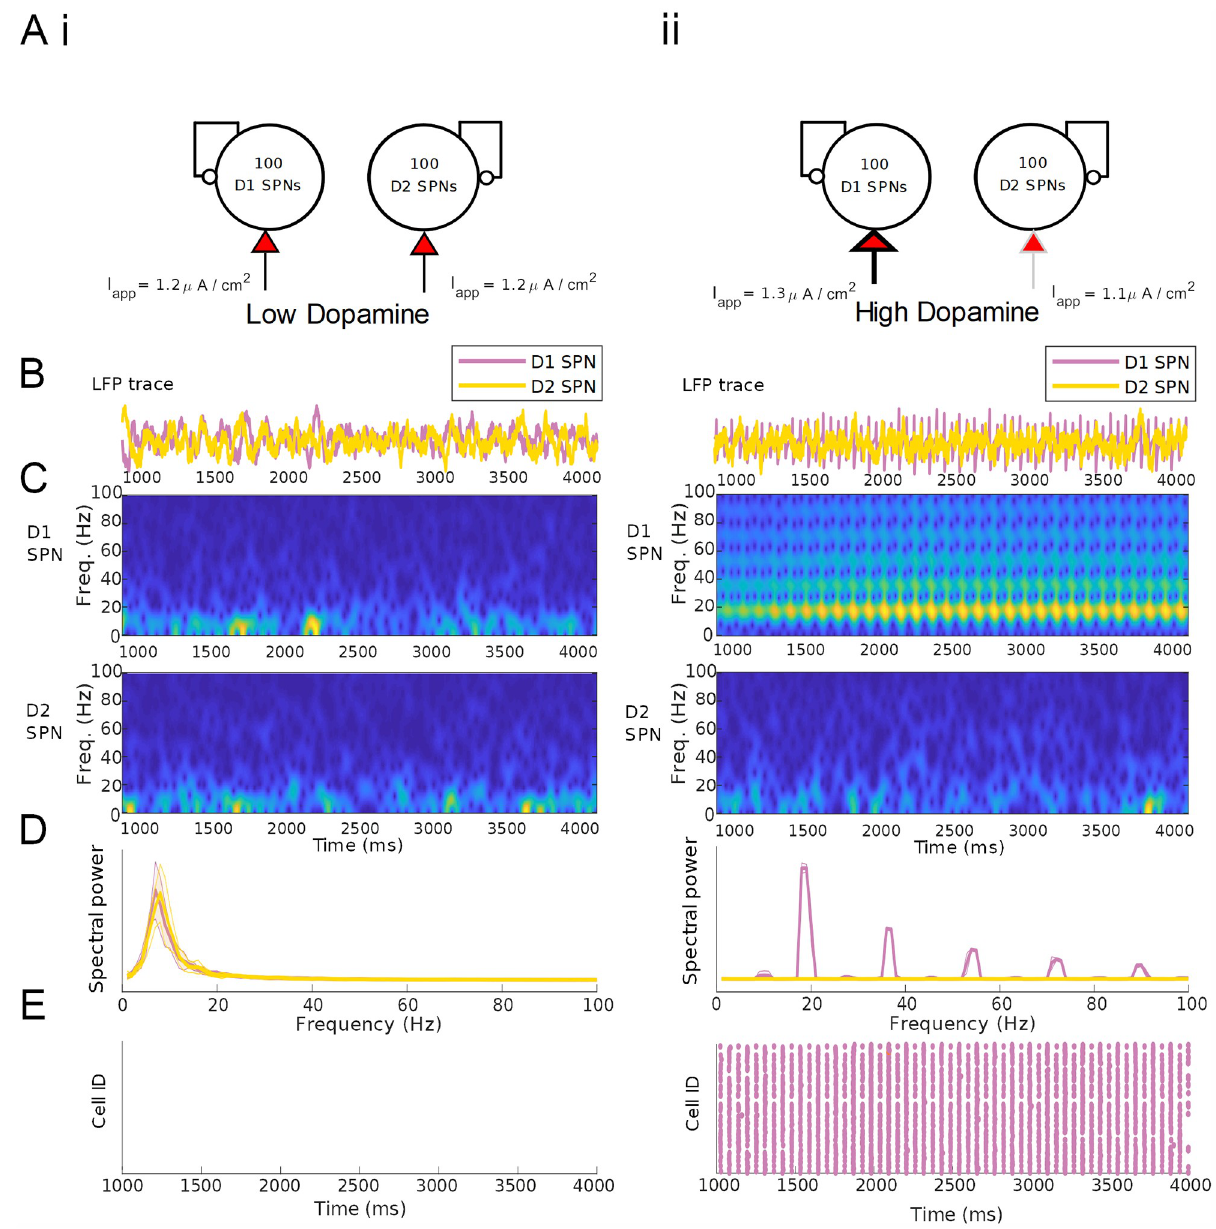
Fig 5. Baseline SPN activity is characterized by β oscillations only in the D1 subnetwork under high DA conditions. (A) Schematics depicting the baseline (i) and high DAergic tone (ii) conditions in an isolated SPN-only network. (B) Mean voltages for the D1 and D2 SPN populations in the two conditions. (C) Spectrograms of mean voltage for the D1 subpopulation (upper) and D2 subpopulation (lower). (D) Power spectral density of D1 and D2 population activity, averaged over 20 simulations. Shading represents standard deviation from the mean. Power spectra are derived using Thomson’s multitaper power spectral density (PSD) estimate (MATLAB function pmtm). (E) Raster plots of SPN population activity. FSIs silences the SPNs. When the FSIs are silent during the δ / θ trough, both D1 and D2 SPN populations are sufficiently excited to produce a β rhythm. Thus, while the SPNs cannot entrain to the γ frequency of FSI inhibition, they are modulated by the FSI-generated δ / θ rhythm. Due to the differences in excitability under high DAergic tone, the D1 SPN subpopu- lation produces a higher frequency β ( * 20 Hz) than does the less excitable D2 subpopulation,